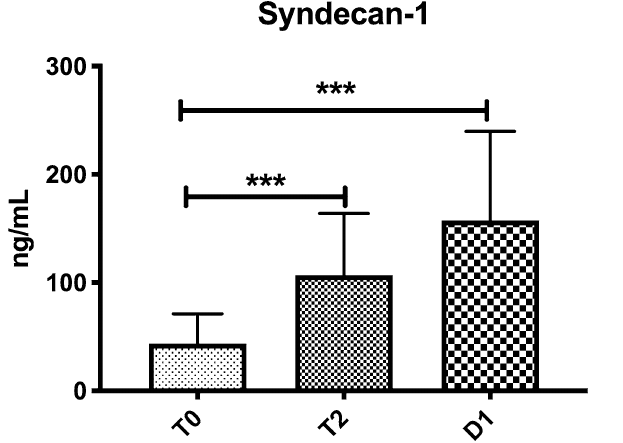
Figure 8. Syndecan-1 levels measured in blood at the beginning of surgery (T0), the end of surgery (T1) and 24 h later (T2). Syndecan-1 was increased at the end of surgery (T1) and this increase persisted at T2 (24 h). Values are represented as median [interquartile, *** p < 0.001.